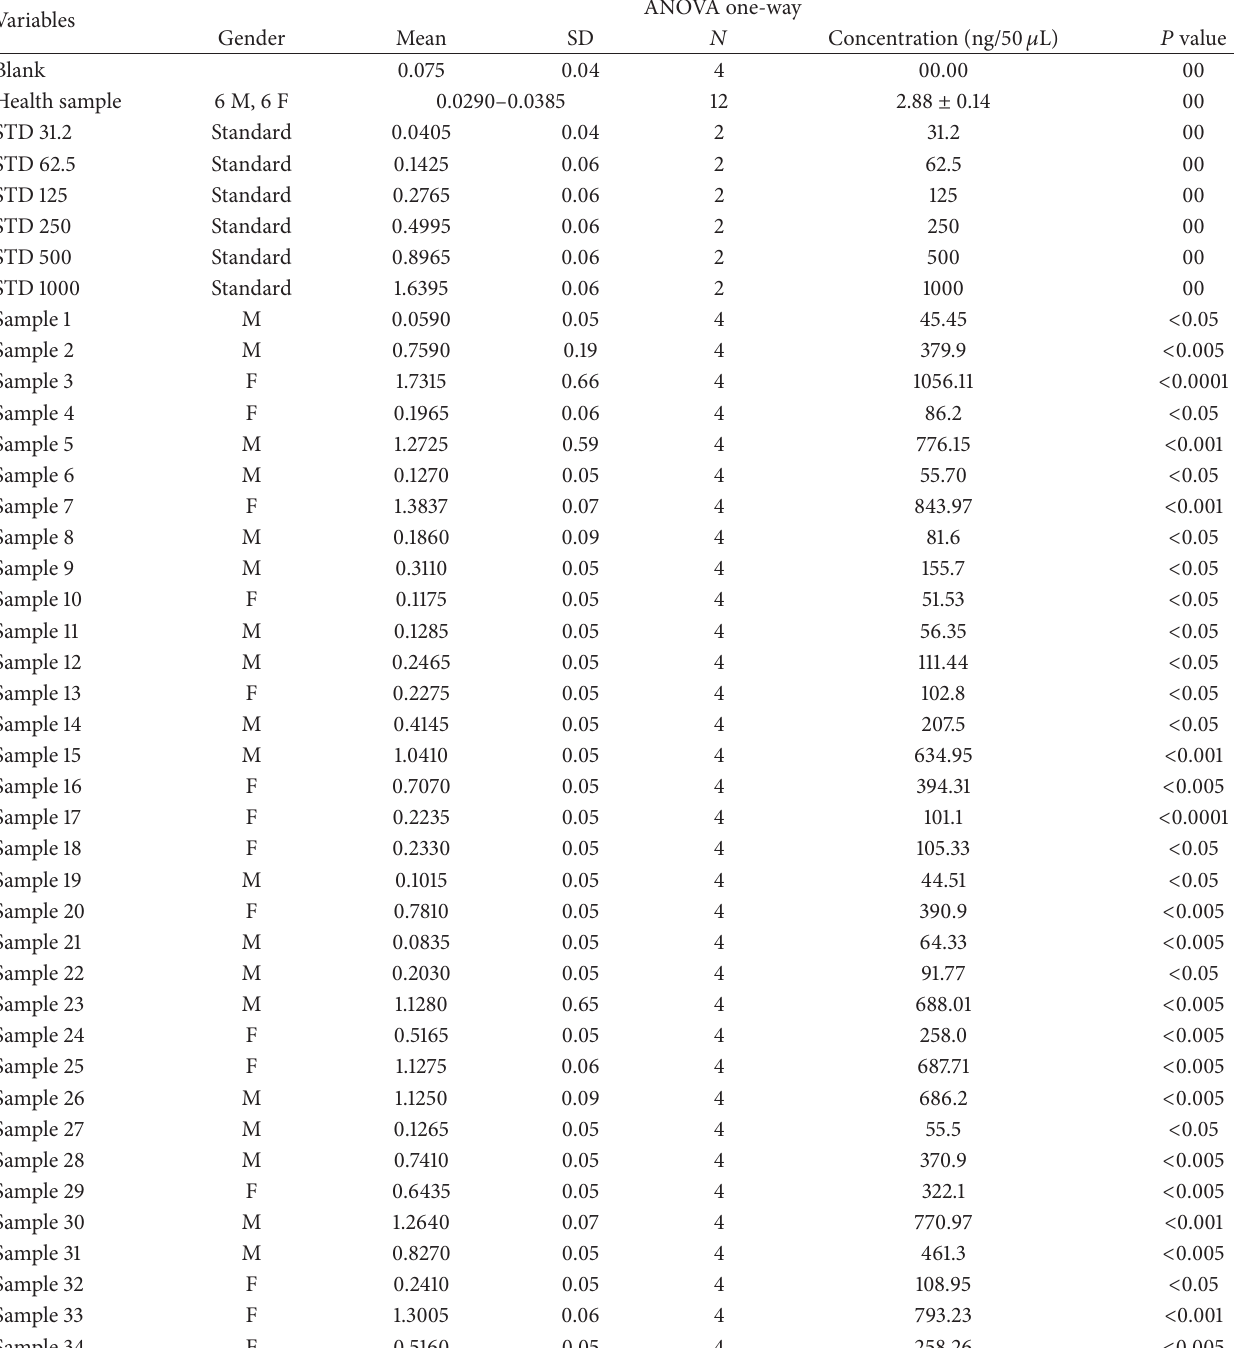
Table 3: Human 𝛽 -defensin concentration in HCV patients